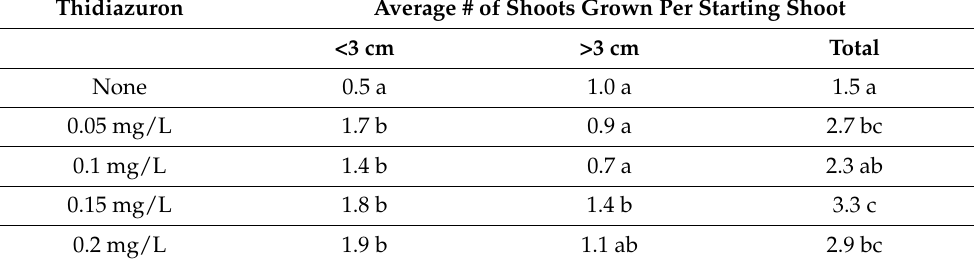
Table 4. Xerophyllum asphodeloides shoot multiplication over two months for three seed sources on 1 MS medium varying in thidiazuron content. 2